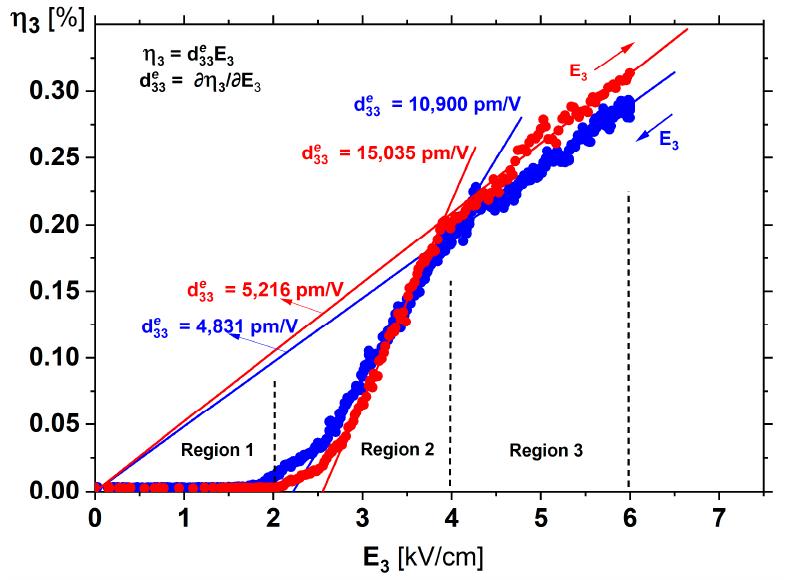
Figure 6. Giant effective piezoelectric effect recorded at 440 K for increasing (red) and decreasing (blue) AC electric field in a PbZr 0.95 ± 0.01 Ti 0.05 ∓ 0.01 O 3 single crystal. For a description of the individual regions, see text.